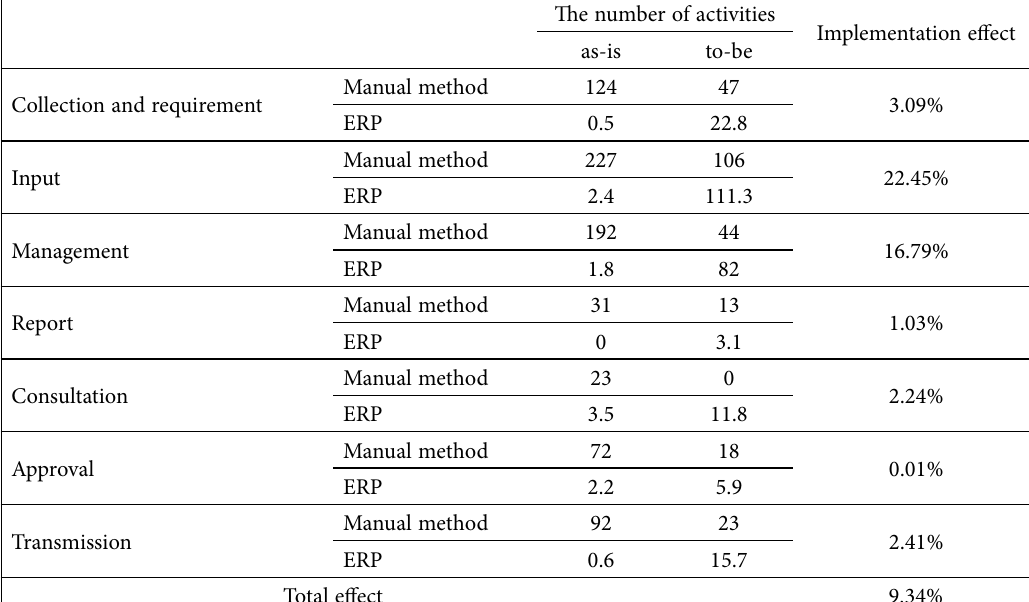
Table 8. Number of activities and effect depending on the purpose of ES